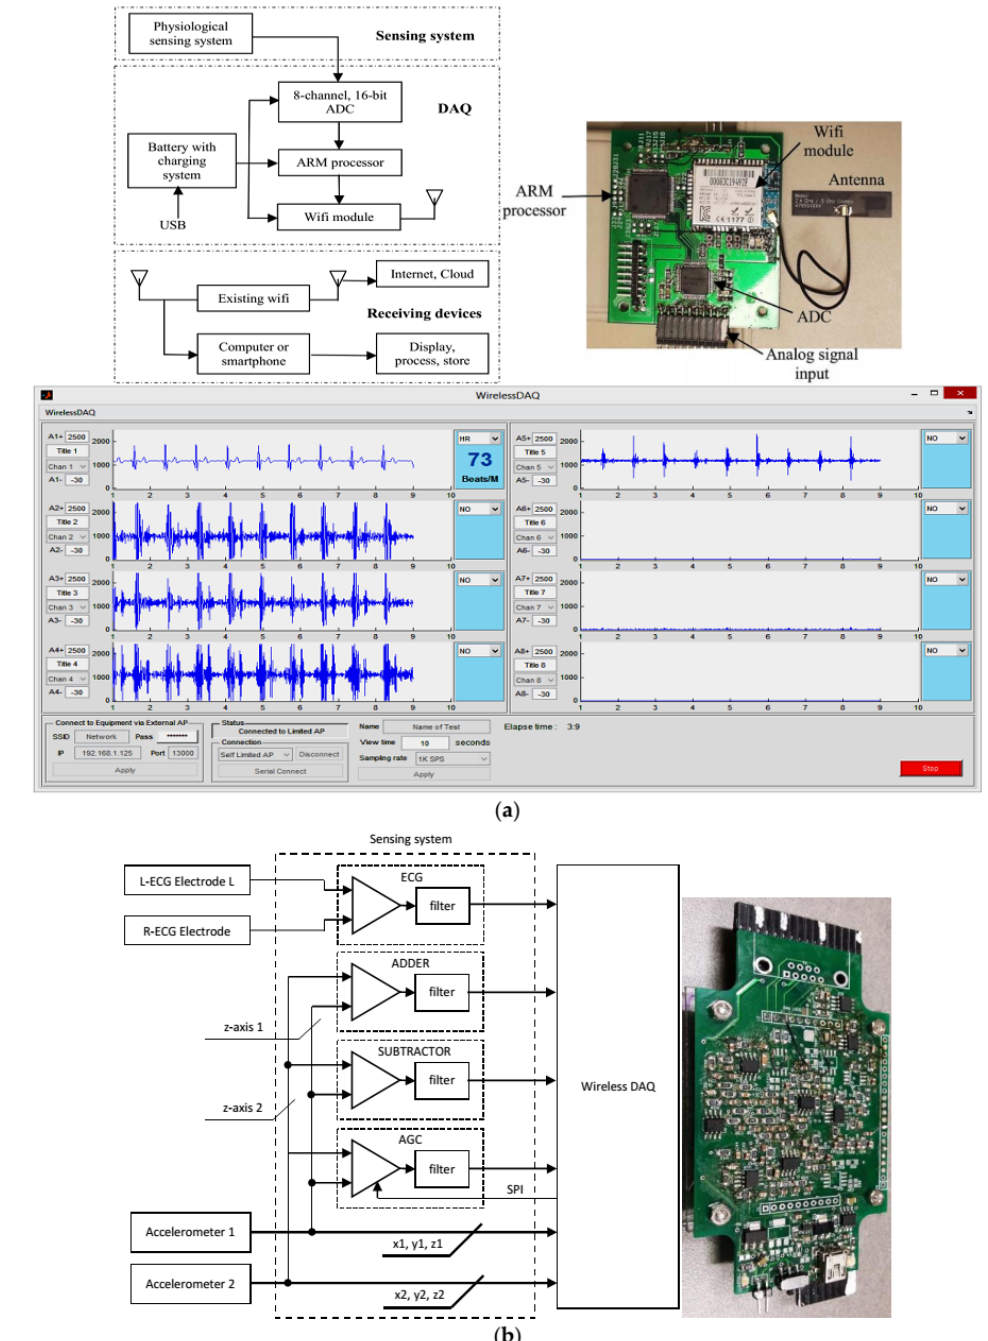
Figure 2. ( a ) Data acquisition system, top-down, clockwise. System block diagram. Photograph of the wireless DAQ (power supply and rechargeable battery are not shown). Screen capture of the DAQ user interface on the computer, ( b ) Block diagram and photograph of the sensing